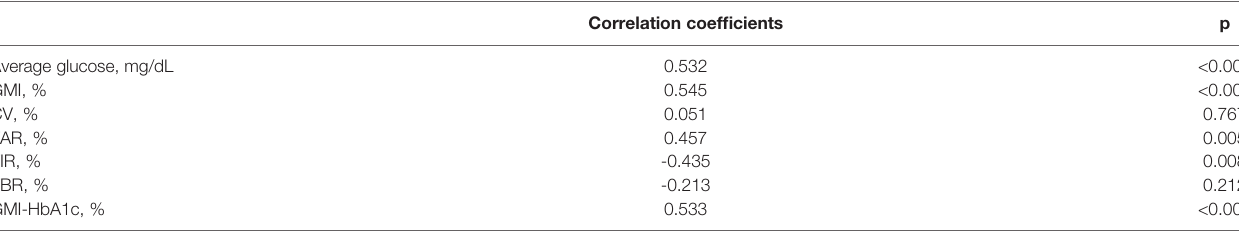
TABLE 2 | Correlation between CGM metrics and ICU stay.